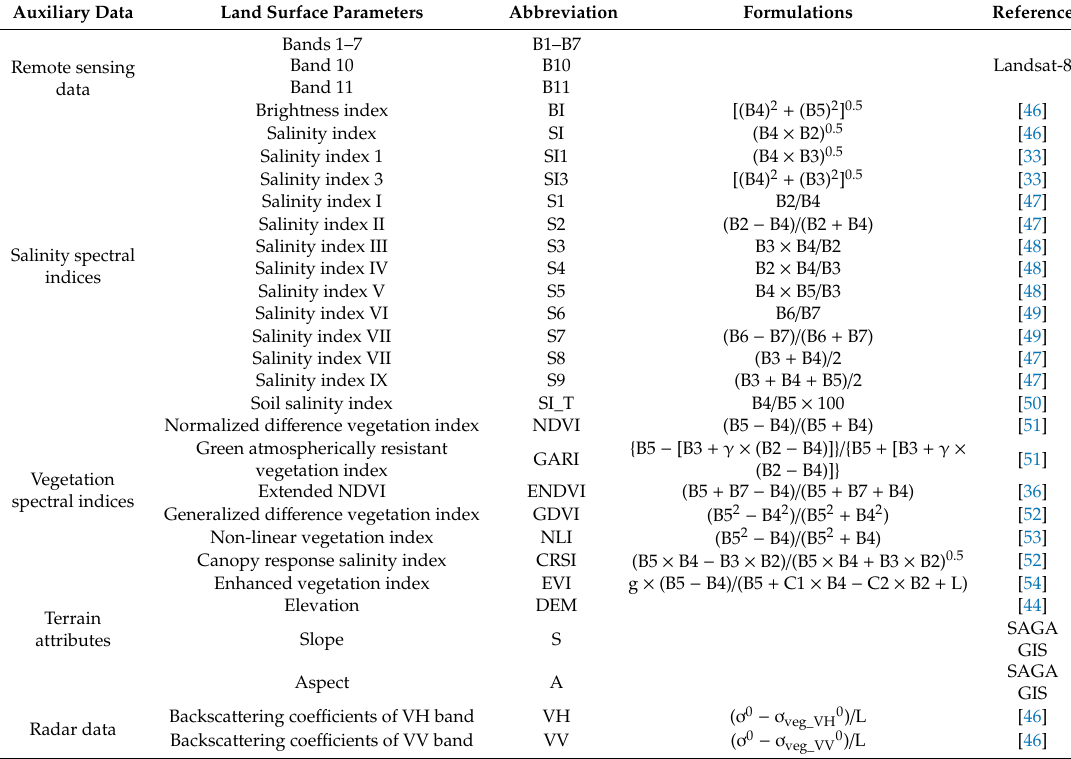
Thirty-five indices including auxiliary data (remote sensing data, terrain attributes, vegetation spectral indices, salinity spectral indices, and radar data) used to estimate soil EC in this study along with their abbreviations, calculation formulae, and the reference of